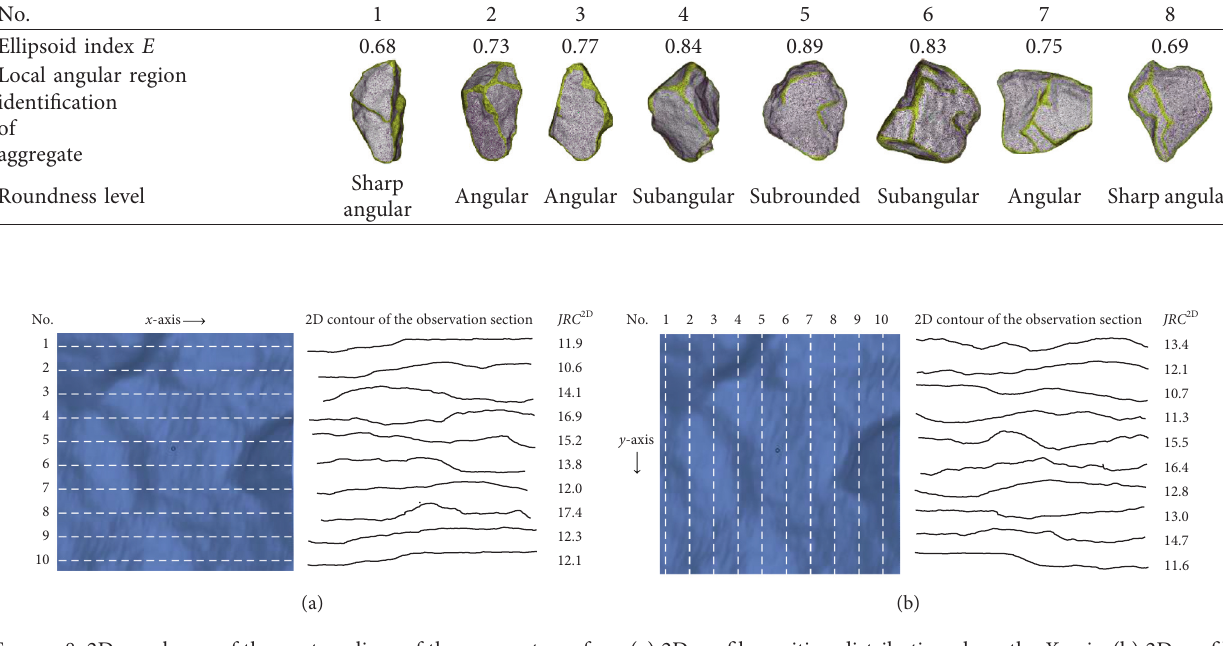
Figure 8: 2D roughness of the contour lines of the aggregate surface: (a) 2D profile position distribution along the X -axis; (b) 2D profile position distribution along the Y